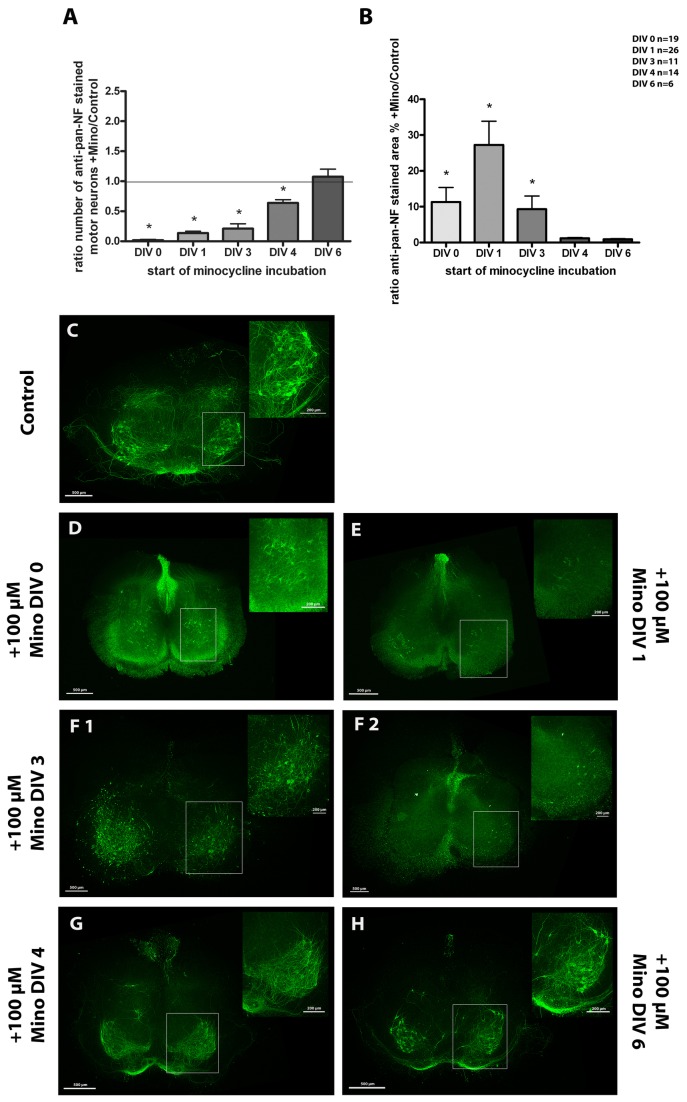
Time series of organotypic spinal cord cultures treated with 100 µM minocycline.(A) shows the number of motor neurons for cultures incubated starting at DIV 0, 1, 3, 4 or 6. In result of minocycline incubation, the number of motor neurons was reduced whereby earlier (and thus longer) incubation times were more effective. One-day treatment (starting at DIV 6) did not influence the number of motor neurons compared to controls. Values show the ratio of +Mino/controls mean ± SD. Ratio of 1 is marked as line to illustrate +Mino value = control value. (B) demonstrates the anti-pan-NF percentage stained neurofilament area for the various incubation times. Minocycline supplement from DIV 0, 1 and 3 onwards resulted in an increased stained area with DIV 1 showing the highest value. In cultures from DIV 4 and 6 onwards, the percentage stained area did not change compared to the control. Statistical analysis was done with a Student’s t-test to compare control and +Mino for each incubation time. Number of samples was n=19 for DIV 0, n=26 for DIV 1, n=11 for DIV 3, n=14 for DIV 4 and n=6 for DIV 6 (1 animal = mean of up to 3 replicates). Significant differences compared to the control are marked with * and demonstrate p<0.05. (C-H) Fluorescence images of organotypic spinal cord cultures stained for anti-pan-NF in green to visualize neurons, especially motor neurons and neuronal filaments. Motor neuronal areas are magnified and marked with a box. Slices were cultivated for 7 days and incubated from DIV 0, 1, 3, 4 or 6 onwards with minocycline. (C) control culture showing various regular motor neurons, neurons and neurites; (D) culture incubated from DIV 0 onwards lacking motor neurons but displaying a clear staining of other neurons like interneurons and sensory neurons. (E) culture incubated from DIV 1 onwards demonstrating only a few neurons at all; (F 1 and 2) cultures incubated from DIV 3 onwards showed degenerating motor neurons like it is seen in (F 1) or lacked motor neurons like it is seen in (F 2). (G) culture incubated from DIV 4 onwards showing regular motor neurons and neurites (H) culture incubated from DIV 6 onwards showing motor neurons and their neurites. Bars = 500 µm, bars in magnified area = 200 µm.